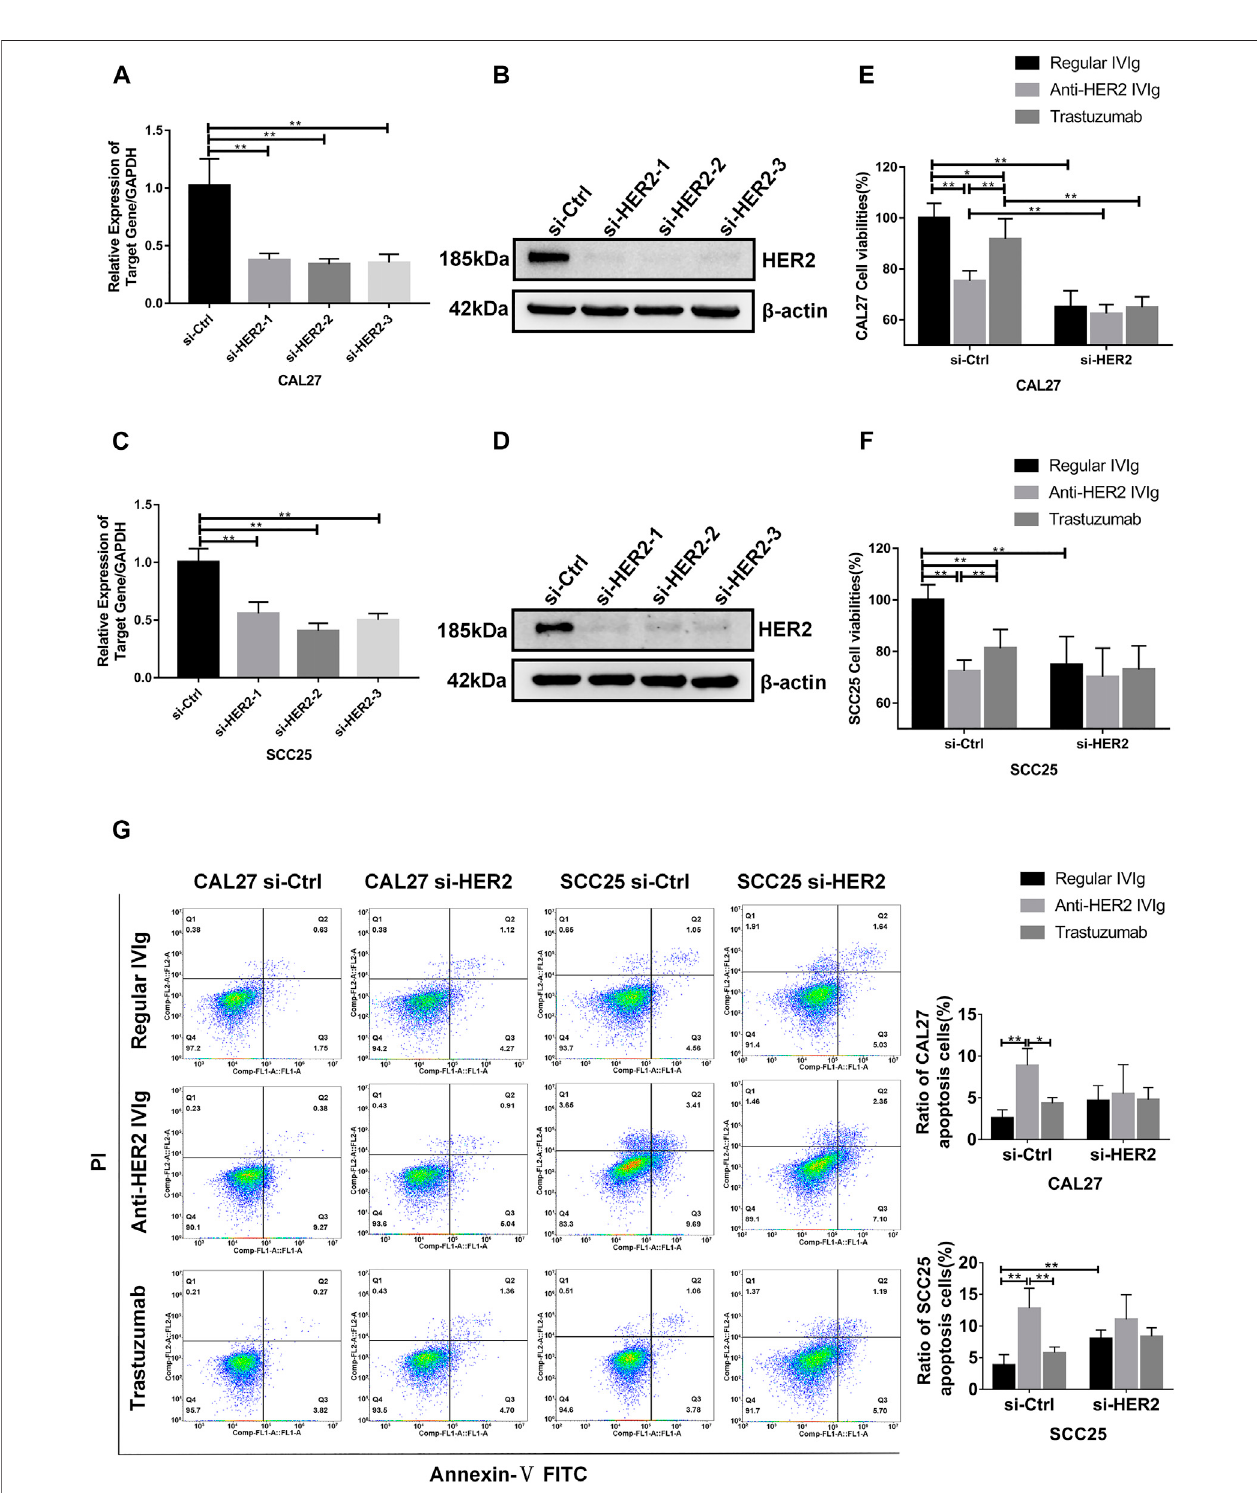
FIGURE 7 | Inhibitory effects of anti-HER2 IVIg on HER2 knockdown OSCC cells. (A – D) Three HER2-speci fi c siRNAs were transfected into CAL27 and SCC25 cells. The expression of HER2 mRNA and protein was then examined by qPCR and Western blot assay, respectively. (E – F) CAL27 and SCC25 cells were transfected witheitherHER2-speci fi csiRNAsorcontrolsiRNAs;OSCCcellsweretreatedfor48 hwithanti-HER2IgG-de fi cientplasmacontaining200 μ g/mltrastuzumab, 5 mg/ml regular IVIg, and 5 mg/ml anti-HER2 IVIg, respectively. The data were expressed as mean ± SD in cell viability (%). (G) CAL27 and SCC25 cells were transfected with either HER2-speci fi c siRNAs or control siRNAs, and then treated for 48 h with anti-HER2 IgG-de fi cient plasma containing 200 μ g/ml trastuzumab, 5 mg/ml regular IVIg,and5 mg/mlanti-HER2IVIg,respectively.Thedatawereexpressedasmean ± SDinproportionofapoptoticcells.IVIg,intravenousimmunoglobulin;si-Ctrl,control siRNA; si-HER2, HER2-speci fi c siRNAs; * p < 0.05; ** p < 0.01.